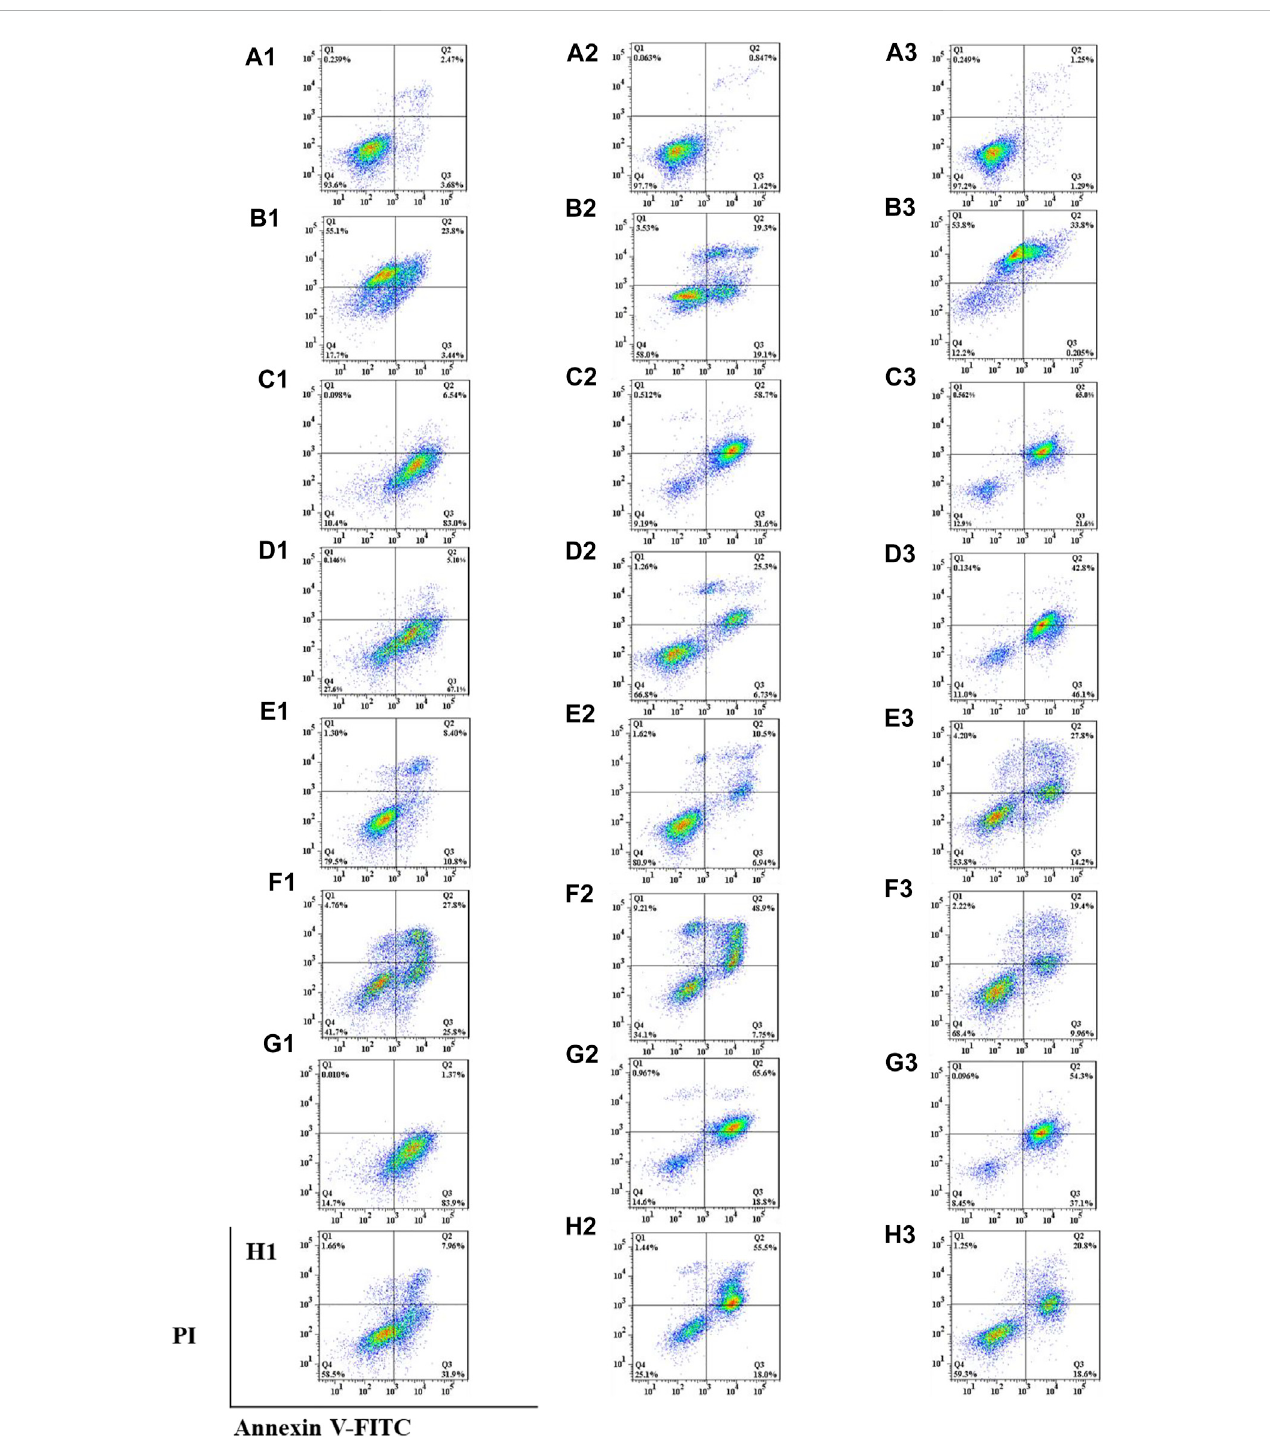
FIGURE 6 All six isolated saponins induce apoptosis in three cancer cell lines. (A1 – H1), A549 cells. (A2 – H2), SMMC-7721 cells. (A3 – H3), HepG2 cells. As negative control, 0.1% (v/v) DMSO was used (An). DOX-treated cultures served as positivecontrol at concentrations of 5, 1,and 5 μ M (Bn). All saponins were added ata concentration of 5 μ M: saponin 1 (Cn), saponin 2 (Dn), saponin 3 (En), saponin 4 (Fn), saponin 5 (Gn), and saponin 6 (Hn), n=1, 2,